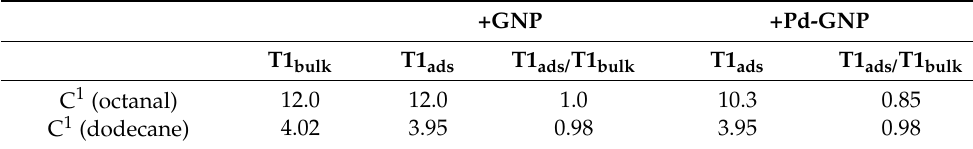
Table 7. Octanal and dodecane T1 bulk and T1 ads resulting from analysis of the inversion recovery curves from 13 C NMR spectra (600